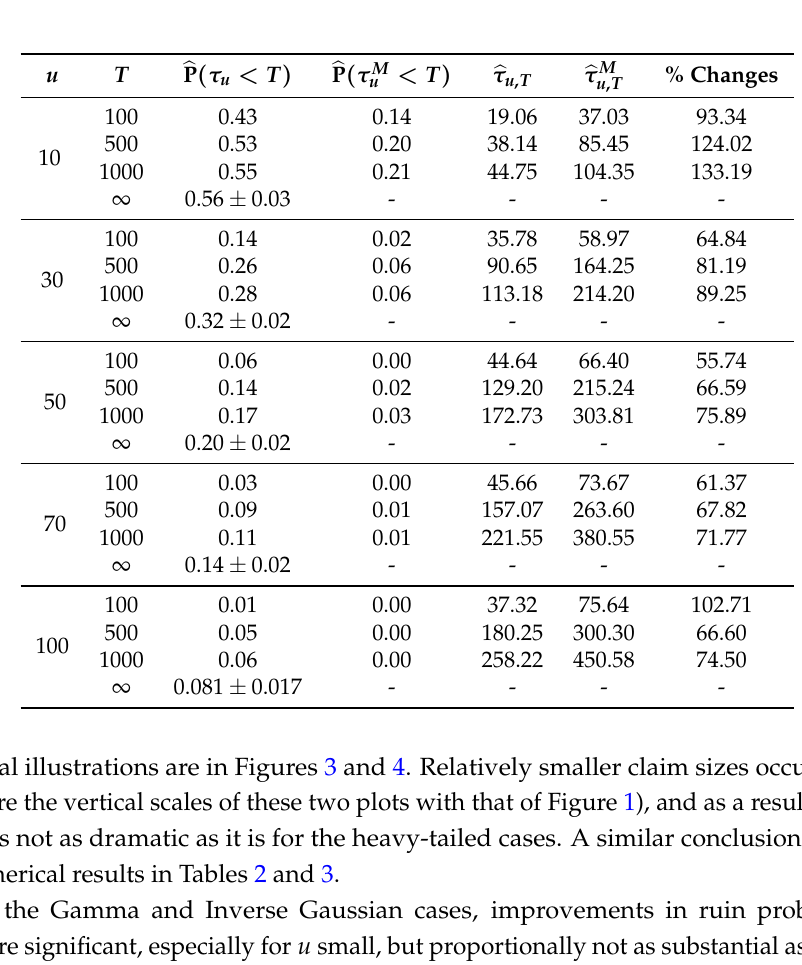
Table 1. LCR reinsurance for Pareto ( 1,2 ) distributed claims. The safety loading is θ = 0.1, expected claim size is µ = 2, claim arrival rate is λ = 1, and each time unit is 0.01 years. Simulations are done with N = 100,000 sample paths. The T = ∞ case refers to the results obtained from Algorithm III in [12].